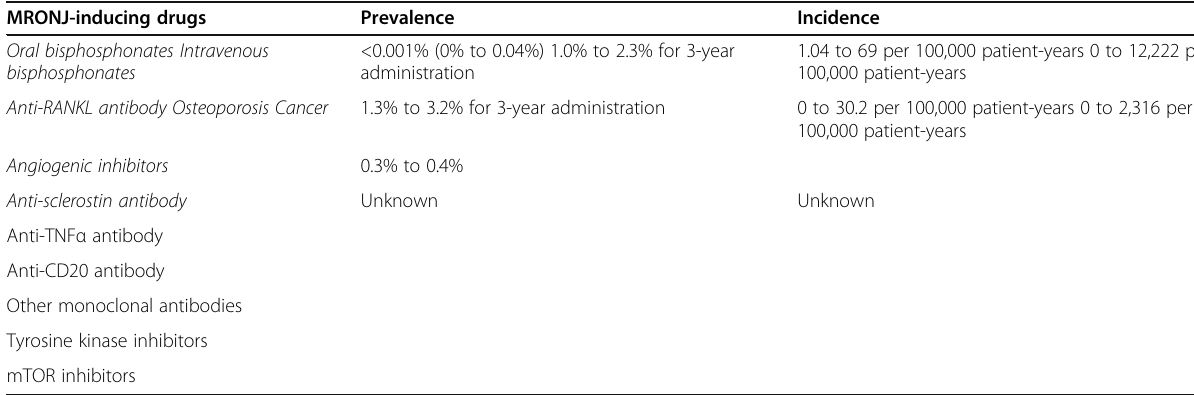
Table 3 Epidemiology of MRONJ MRONJ-inducing drugs Prevalence